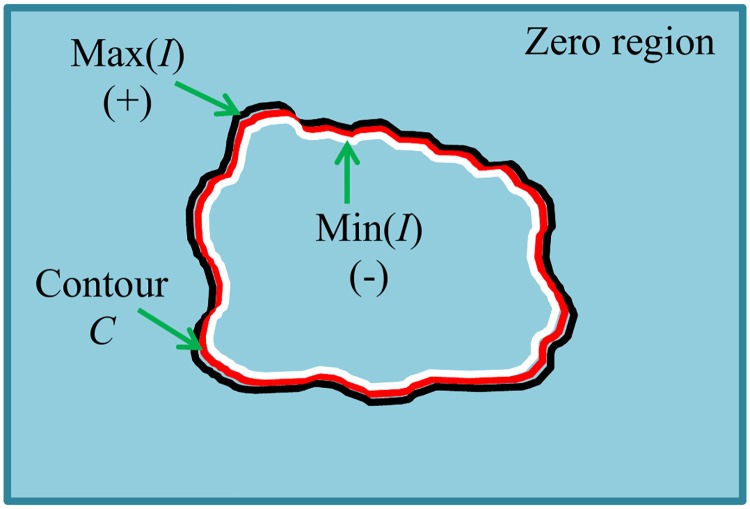
Signs of a local SPF function.It is positive along the outer boundary, negative along the inner boundary and zero elsewhere.